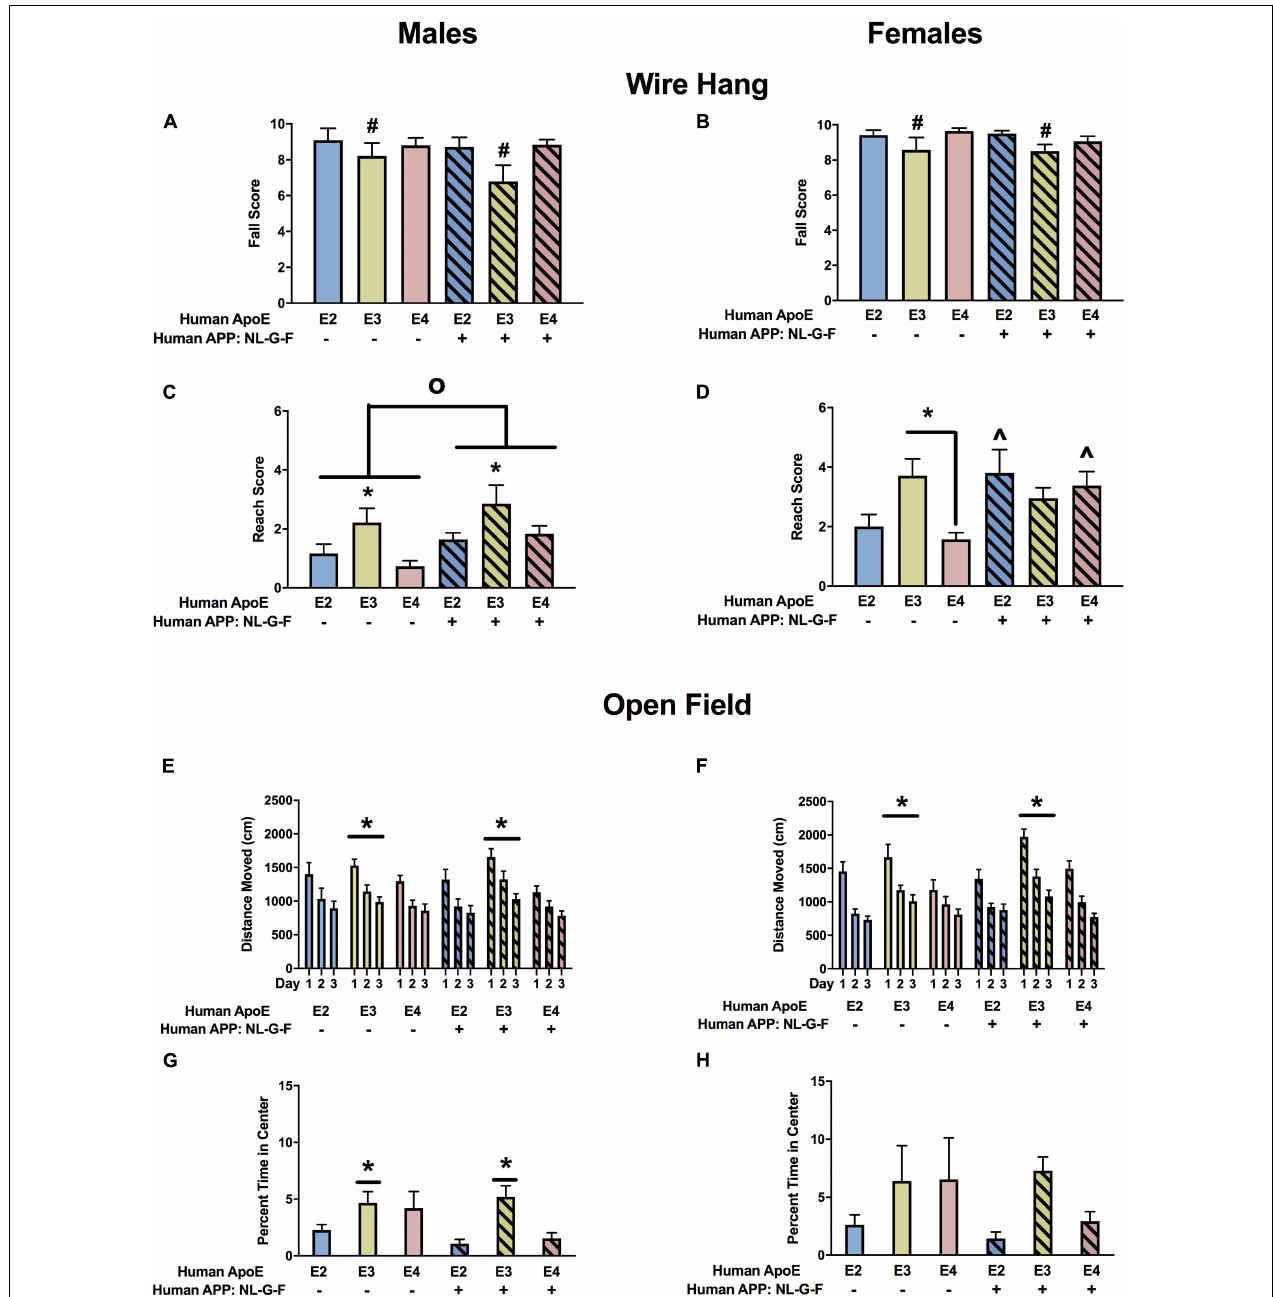
FIGURE 4 | Performance of males (A,C,E,G) and females (B,D,F,H) in the wire hang and open field tests at the 6-month time point. (A) There was an effect of APOE on fall scores of males in the wire hang test. There was a trend toward lower fall scores in E3 than E2 ( p = 0.065) and E4 males ( p = 0.050). (B) There also was an effect of APOE on fall scores of females in the wire hang test. There was a trend toward lower fall scores in E3 than E2 females ( p = 0.076). (C) There was an effect of APOE and APP on reach scores of males in the wire hang test. Reach score were higher in E3 than E2 and E4 males. * p < 0.05. In addition, reach scores were higher in NL-G-F mice. o p < 0.05. (D) There was an effect of APP and an APP × APOE interaction for reach scores of females in the wire hang test. Reach scores were higher in E3 than E4 females. * p < 0.05. Reach score were higher in NL-G-F/E2 and NL-G-F/E4 than E2 and E4 females, respectively. ∧ p < 0.05. (E) There was an effect of APOE on activity levels of males in the open field test. E3 males were more active than E4 males. * p < 0.05. (F) There also was an effect of APOE on activity levels of females in the open field test. E3 females were more active than E2 and E4 females. * p < 0.05. (G) In males, NL-G-F/E2 and NL-G-F/E4 mice spent less time in the center of the open field than E2 and E4 mice, respectively. This was apoE isoform-dependent and not seen in NL-G-F/E3 and E3 mice. In the absence of hAPP, E2 mice spent less time in the center of the open field than E3 or E4 mice. In contrast, in the presence of hAPP, NL-G-F/E2 and NL-G-F/E4 mice spent less time in the center of the open field than NL-G-F/E3 mice. * p < 0.05. (H) In females, E2 mice spent less time in the center of the open field than E3 or E4 mice. * p < 0.05.